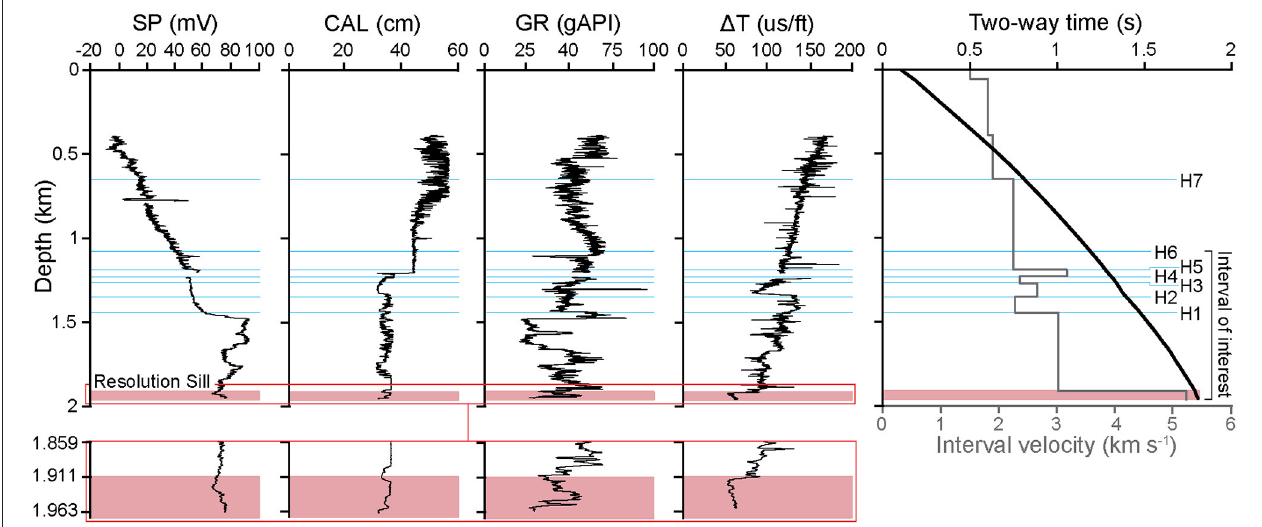
FIGURE 4 | Spontaneous potential (SP), Caliper (CAL), Gamma ray (GR), and Sonic ( 1 T) logs from the Resolution-1 borehole plotted against depth. A plot of two-way time and interval velocity changes with depth is also shown. The locations of the mapped horizons and the Resolution Sill are highlighted.